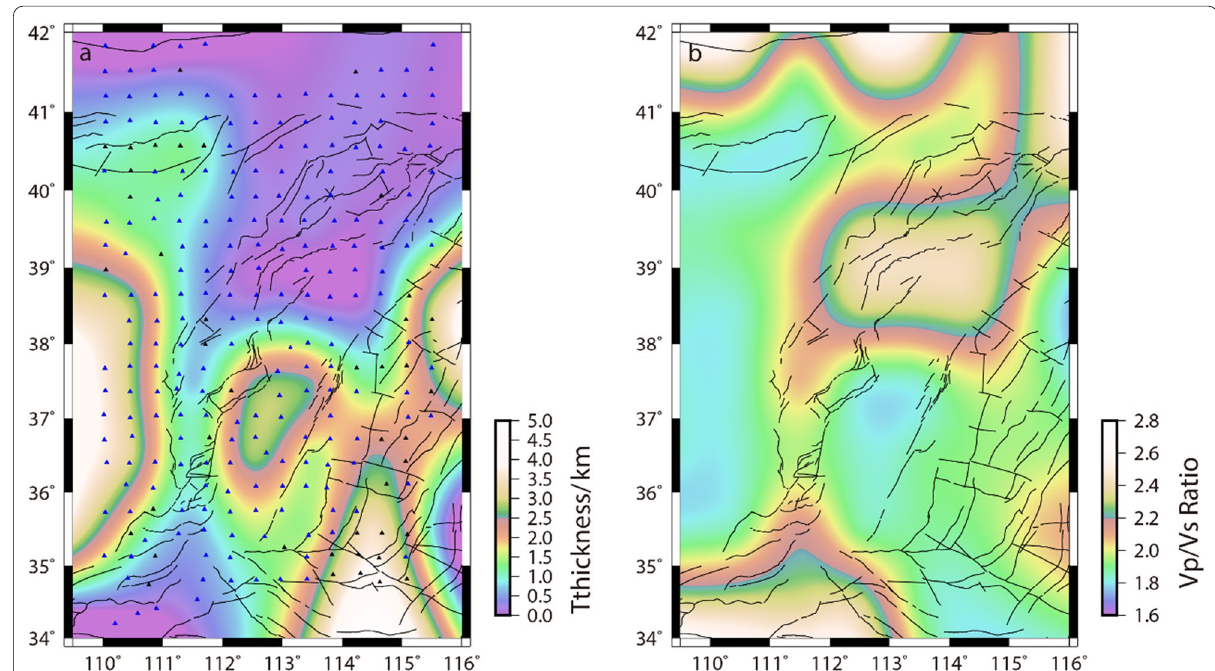
Fig. 2 Sedimentary thickness and Vp/Vs ratio distribution from CRUST1.0 in the study